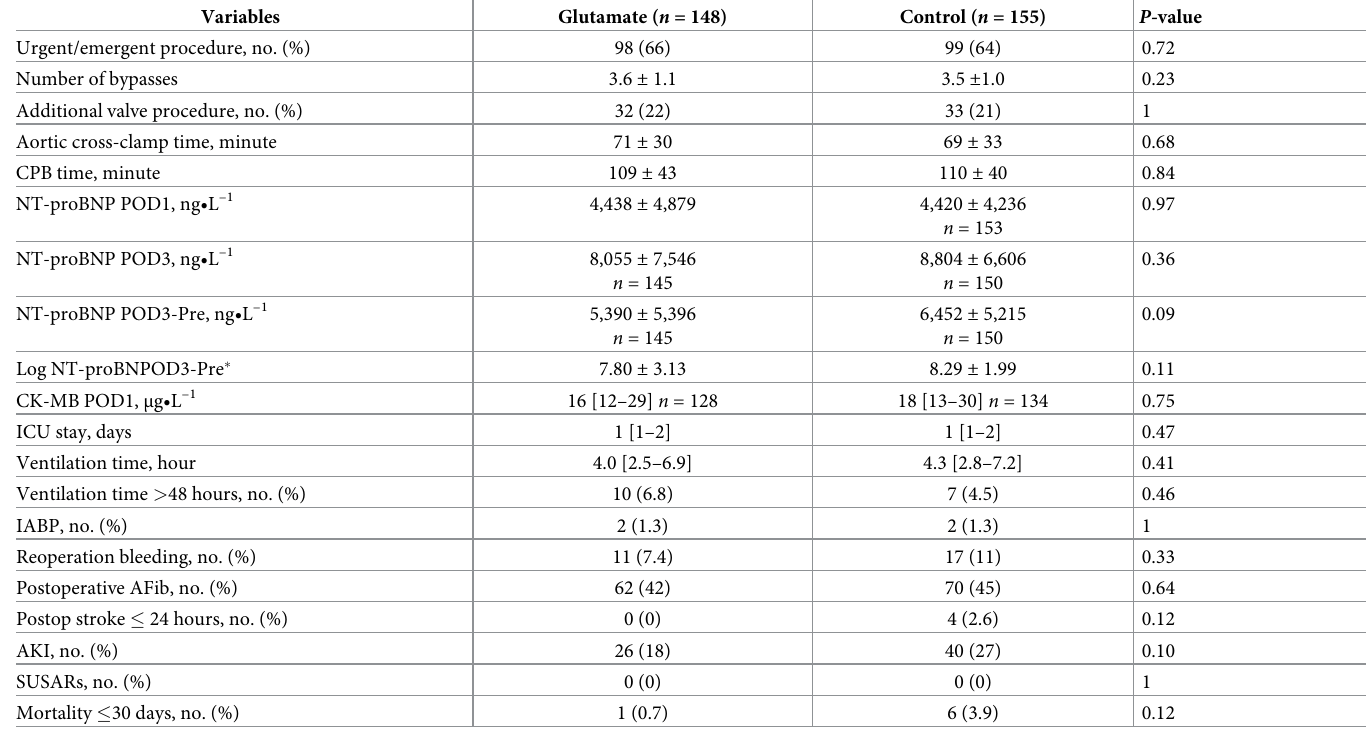
Table 2. Intraoperative and postoperative characteristics of the glutamate group and the control group (saline).